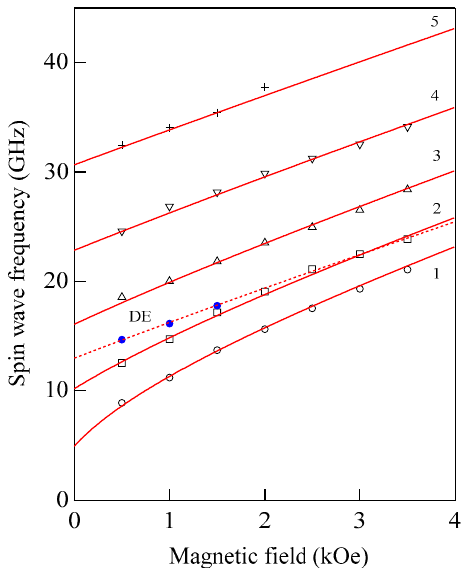
Figure 7. BLS spectrum observed from a 1000 ± 50 Å thick Co 85 Nb 12 Zr 3 film prepared by means of rf-magnetron sputtering from alloy target onto glass substrate. Labels 1–5: SSW mode number; DE: DE surface mode. (Copyright (1994) The Japan Society of Applied Physics.) [62].